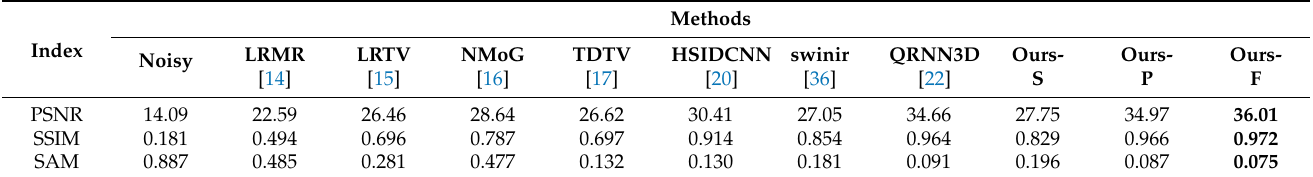
Table 5. The denoising results in the complex mixture noise case on the Pavia University dataset.